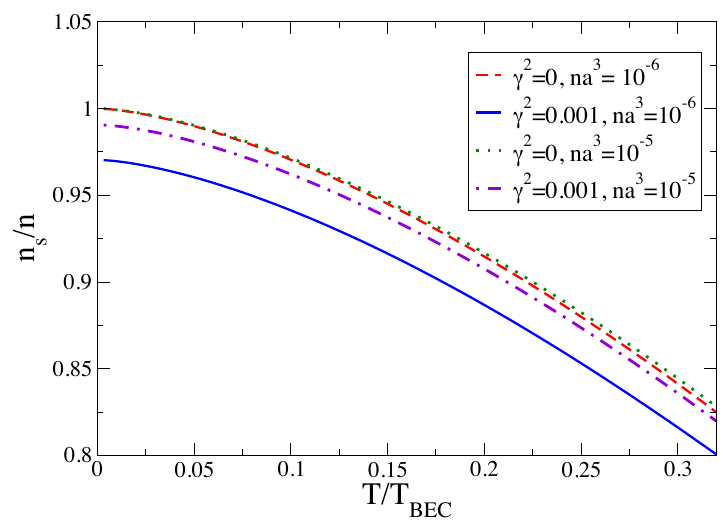
Figure 1. Plot of superfluid fraction in presence and absence of an uncorrelated disordered potential. The curve are derived from the two-fluid assumption n = n s + n n , with the normal contribution n n given by Equation (52). The temperatures are in units of T BEC = 2 π ¯ h 2 n 2/3 / ( mk B ζ ( 3/2 ) 2/3 ) , i.e., the condensation temperature of an ideal Bose gas. The solid blue line and the dot-dashed violet one represent the behaviour of n s / n in the presence of a disordered potential with γ 2 = 0.001 for two different values of the gas parameter na 3 s = 10 − 6 and 10 − 5 , respectively. For the same values of na 3 s , the dashed red line and the dotted green correspond the case where there is no disorder contribution ( γ 2 =